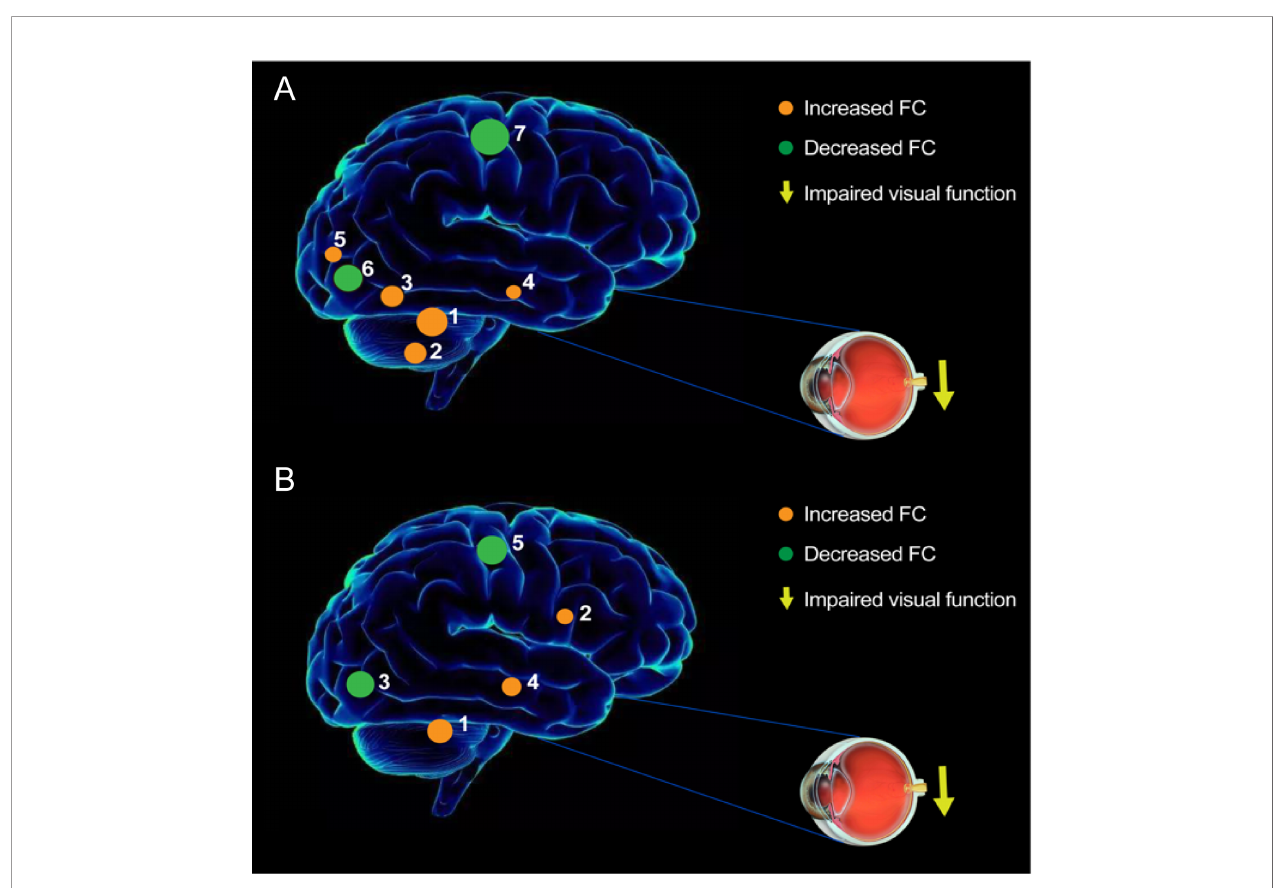
FIGURE 8 | The FC pattern results of left V1 (A) and right V1 (B) in the iridocyclitis group. (A) Compared with HCs, the FC of left V1 in patients with iridocyclitis were increased to various extents: [1] left cerebellum crus1 (t=4.1486); [2] left cerebellum 10 (t=3.5071); [3] left inferior temporal gyrus (t=3.281); [3] right inferior temporal gyrus (t=3.3436); [4] right hippocampus (t=2.8445); [5] left superior occipital gyrus (t=3.2622), and the following areas decreased: [6] bilateral calcarine (t=-4.8233); [7] left postcentral gyrus (t=-4.6021); [7] right postcentral gyrus (t=-4.4712). (B) Compared with HCs, the FC of right V1 in patients with iridocyclitis were increased to various extents: [1] left cerebellum crus1 (t=4.094); [2] bilateral thalamus (t=4.4152); [4] left middle temporal gyrus (t=3.6074), and the following areas decreased: [3] bilateral calcarine (t=-4.4069); [5] left postcentral gyrus (t=-4.0193); [5] right postcentral gyrus